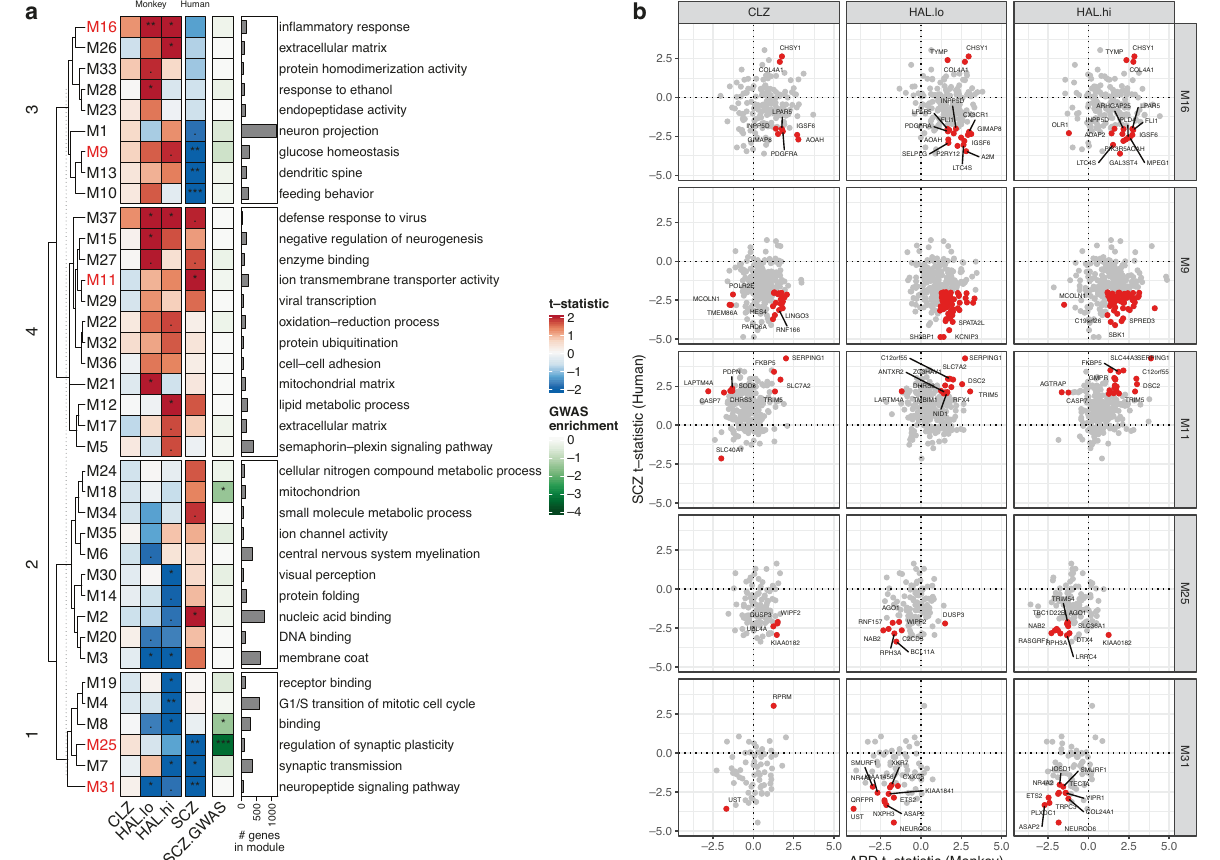
Fig. 2 Consensus WGCNA between human and macaque DLPFC transcriptome data. a Relationship of module eigengenes to APD use in macaque (CLZ = clozapine, HAL.lo = low-dose haloperidol; HAL.hi = high-dose haloperidol) and humans with SCZ (data from HBCC). Heat map shows t -statistic from linear regression illustrating module eigengene directionality (same color indicates concordance; two-sided t test signi fi cance level. *** p < 0.001, ** p < 0.01, * p < 0.05. Hierarchical clustering of rows with Euclidean distance cut at the level of four branches was used for better visibility. Heat map annotation shows the number of genes in each module and the most over-represented gene ontology term (based on Fisher ’ s exact test; excluding terms with ≤ 3 hits). SCZ.GWAS: Enrichment (Fisher ’ s exact test) of prioritized genes from the 2022 SCZ GWAS [15]. For details on the statistical tests and FDR-corrected p values, see Supplementary Table S2. b Relationships of individual genes to APD exposure in macaque ( x -axis) and humans with SCZ ( y -axis) for fi ve example modules with predominantly divergent (M16, M9) or convergent (M11, M25, M31) gene expression patterns (shown as t -statistics). For visualization purposes, the top genes with nominal p < 0.05 for SCZ and p < 0.25 for each APD in macaques are highlighted in red. For a full list of genes and enriched gene ontology terms, see Supplementary Table APD intake, which can span several decades. APD-negative macaque DLPFC [19]. We found no signi fi cant cell-type shifts individuals are typically not naïve to APD treatment since except a slight decrease in glutamatergic neurons in animals practically all patients diagnosed with SCZ are prescribed APDs. treated with high-dose haloperidol, possibly indicating cytotoxic APDs exert complex effects on the brain transcriptome. Gene effects (Fig. 3b and Supplementary Fig. S5d). Together with the expression data from macaques treated with clozapine and cell-type deconvolution results in humans, these data suggest that haloperidol indicated that APD exposure could alter gene any inferred cell-type shifts observed in SCZ are likely unrelated to expression in the same direction as observed in human SCZ APD exposure. samples for some genes and the opposite direction for other genes. Although the macaque data re fl ect the transcriptional effects of APD intake alone, the data are limited by sample size, DISCUSSION potential differences between species, and differences in the APD We show that APD exposure at the time of death confounds SCZ- exposure (6 months for macaques versus typically many years for associated differential gene expression in postmortem brain. humans with variable regimens and compliance). Nonetheless, These fi ndings suggest that some of the differential gene some convergent effects between APD exposure in macaques and expression previously attributed to SCZ may in fact, be driven SCZ in humans support the conclusion that APDs contribute to by APD exposure. This is especially true among individuals treated (and may thus confound) gene expression changes observed in with the atypical APDs commonly used in recent years. The more SCZ. Interestingly, several modules with a convergent pattern of prominent SCZ gene expression signature in these individuals APD and SCZ effects (typically downregulated) were enriched for could re fl ect gene expression changes induced by APDs synaptic function. These modules also showed discrepancies themselves, the illness itself, or a combination of both. An between haloperidol and clozapine administration in macaques, important consideration is that toxicological tests only re fl ect with haloperidol effects being more convergent, and clozapine acute effects of APD use at the time of death rather than chronic